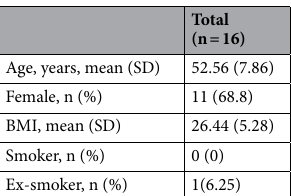
Table 2. Healthy donors’ characteristics. BMI body mass index, % percentage after excluding missing values.